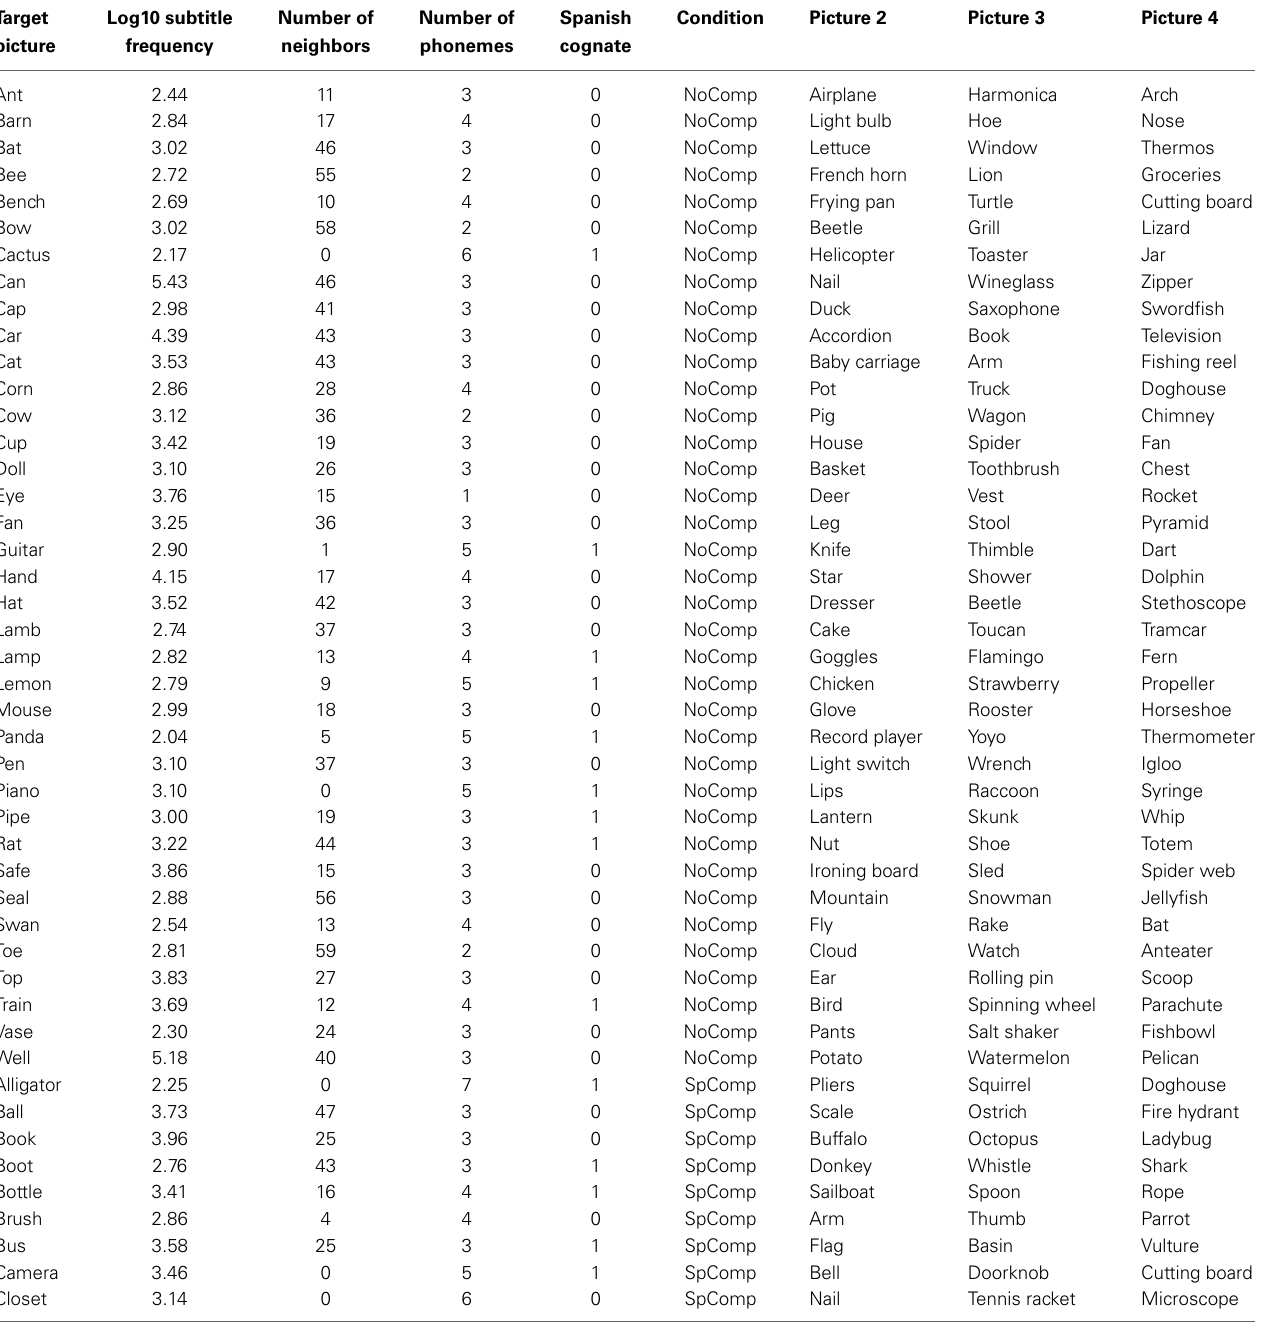
Table A1 | Target word characteristics and distractor pictures used in the